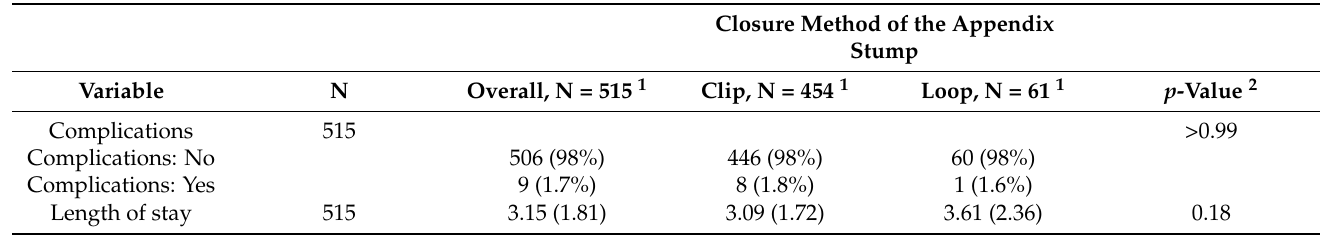
Table 3. Characteristics of patients’ groups and complications characteristics.